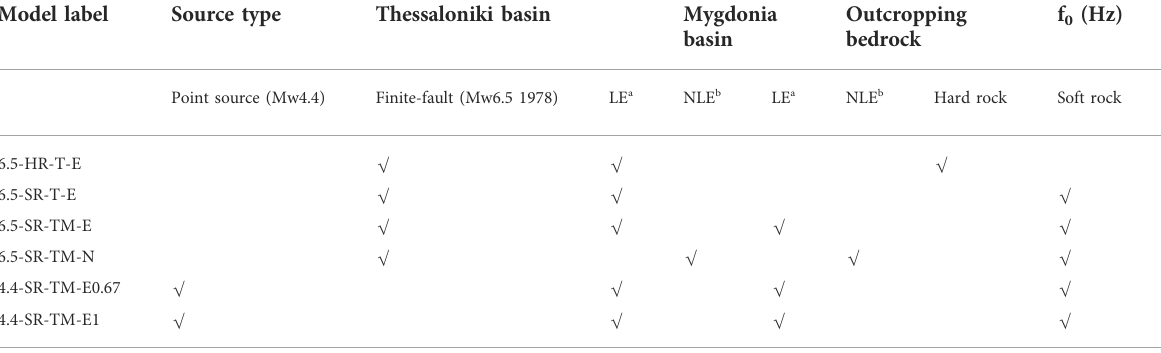
TABLE 1 Numerical simulations performed in this study for validation and sensitivity purposes. Model